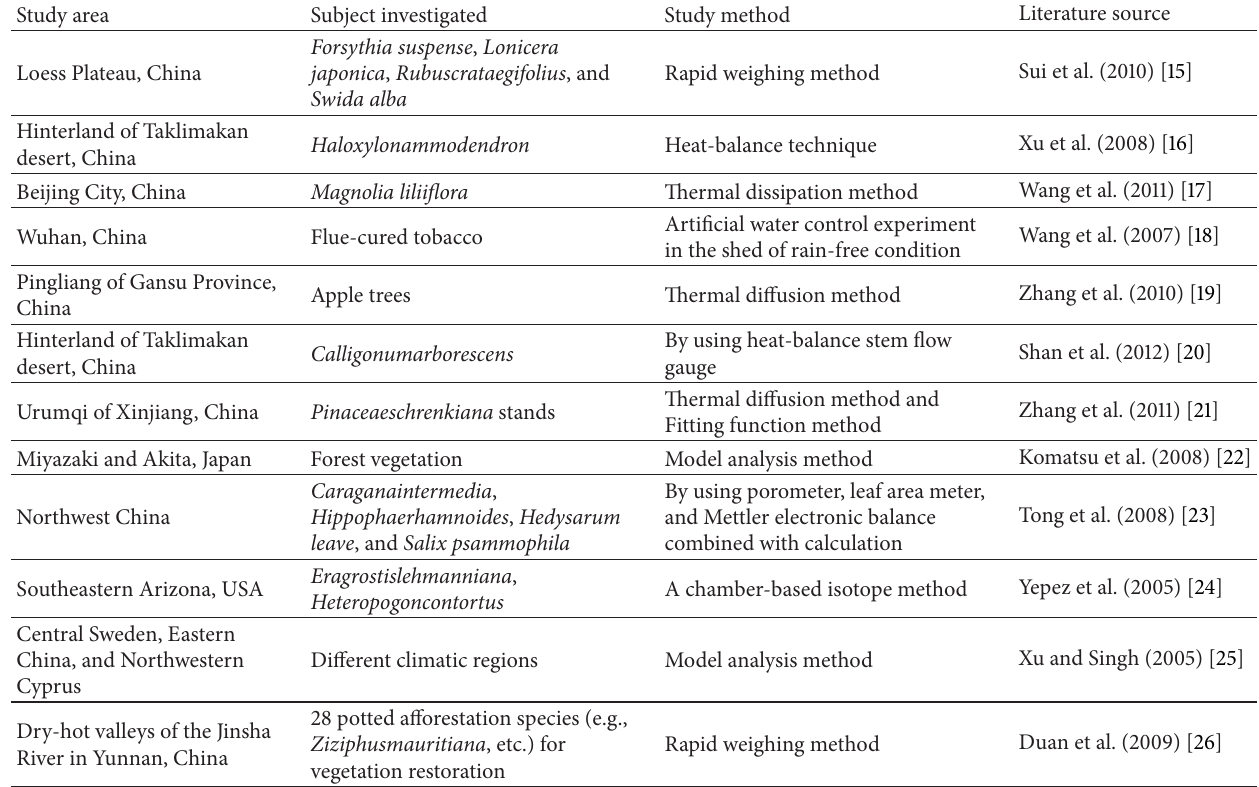
Table 1: Typical cases of study on transpiration characteristics of plant